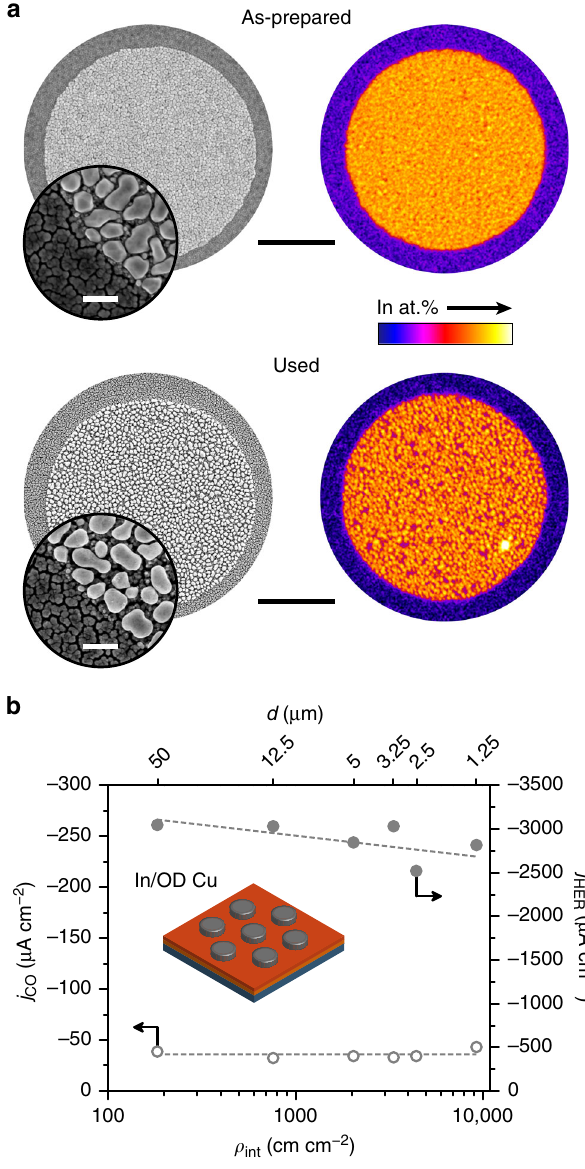
Fig. 7 Microscopy and elemental distribution of indium, and catalytic activity for CO and H 2 evolution over structured In/OD Cu electrodes. a Representative SEM micrographs and EDX chemical map of indium of (top) as-prepared electrodes ( d = 12.5 μ m) after 6 days stored under ambient conditions and (bottom) upon reaction. Scale bars: 5 μ m (main images), 200 nm (insets). b Partial current density for CO ( j CO ) and for H 2 ( j HER ) in eCO 2 RR electrolyses as a function of the interfacial density ( ρ int ). The corresponding island diameter ( d ) is also indicated and the trendlines are added as a visual aid. The reaction was carried out in CO 2 -saturated 0.1 M KHCO 3 (pH 6.7) at − 0.6 V vs.